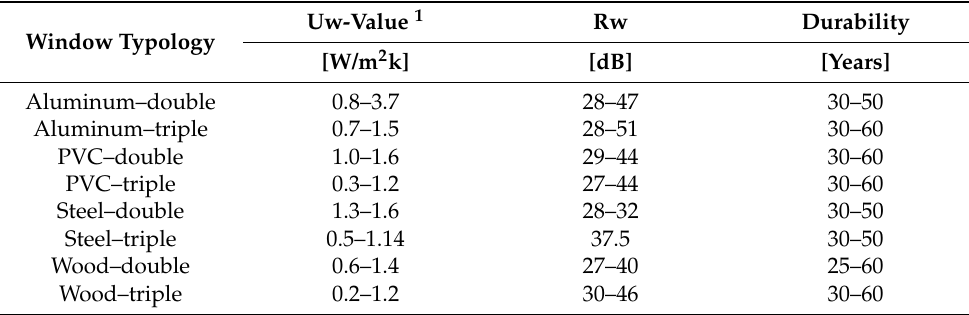
Table 4. Maximum and minimum value of the parameters characterizing the different window